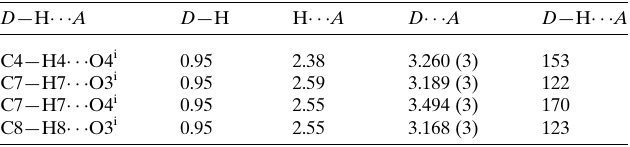
Table 2 Hydrogen-bond geometry (A˚ , (cid:3)